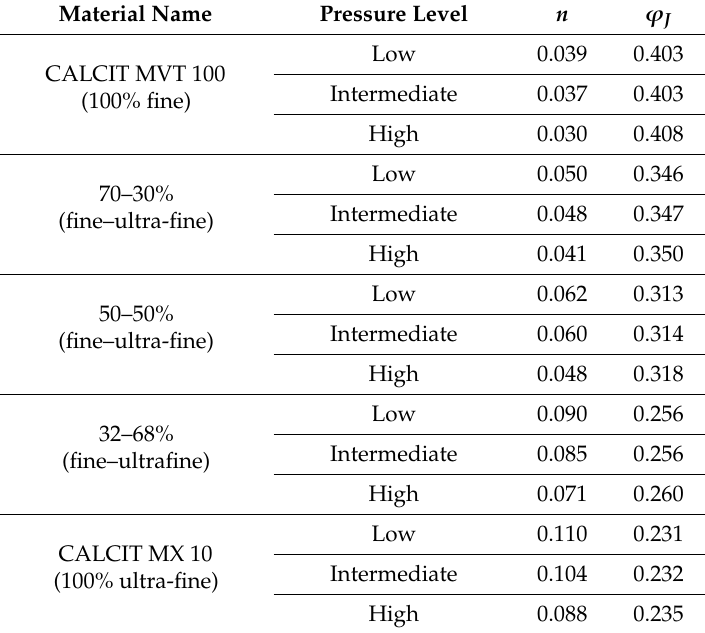
Figure 4. Specificparticlevolumefraction(1/ ϕ )asafunctionofdimensionlessappliedconsolidationstress. Figure 4. Specific particle volume fraction ( 1 𝜑⁄ ) as a function of dimensionless applied consolidation stress. Table 4. Compressibility index and calculated jammed particle volume fraction of di ff erent mixtures during various sets of applied